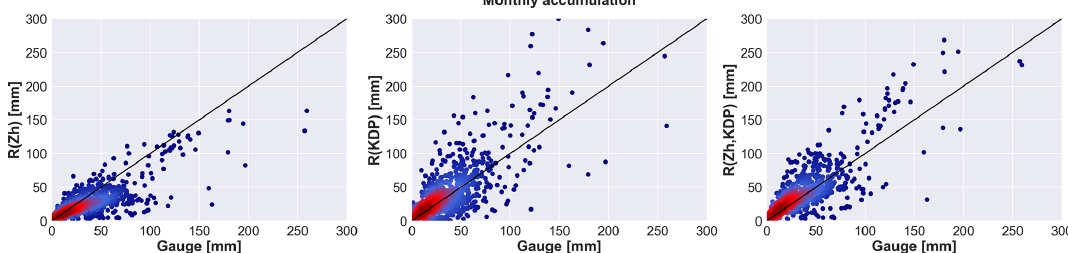
Figure 10. Monthly accumulations for Italy, 2012–2016. The corresponding verification measures are presented in Table 8. The number of radar–gauge data pairs with 42 gauges is 675. Z H is not corrected for